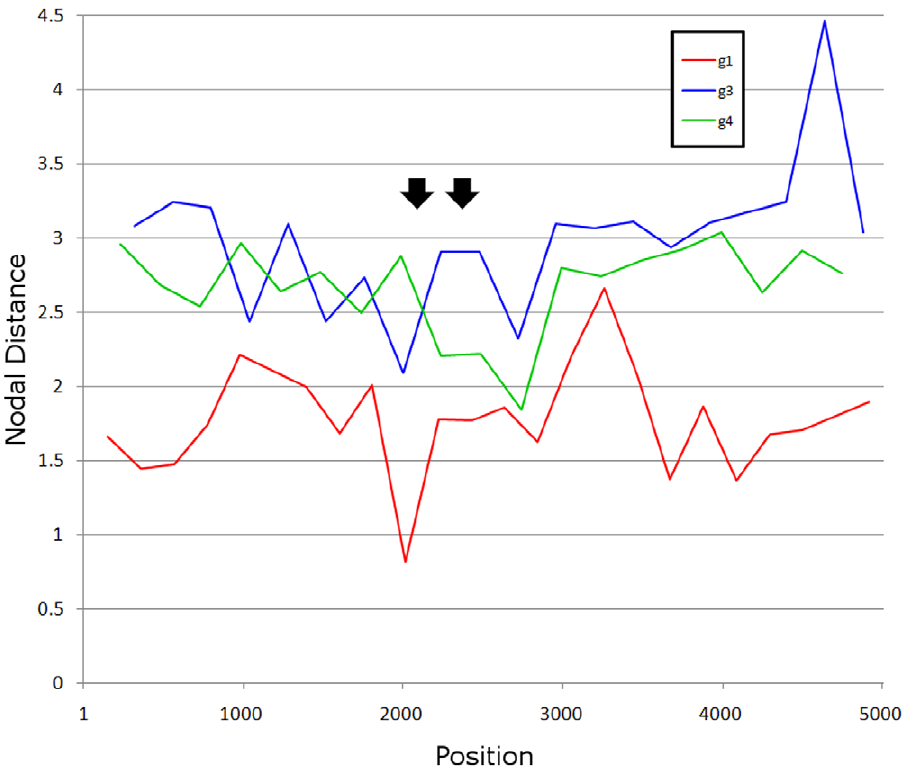
Figure 7. Nodal distance. The nodal distance calculated for consecutive non-overlapping windows in ORF1. The closer to zero the nodal distance is for a window, the more it is like the nodal distance for the full-length ORF1. Black arrows delineate the PPR.